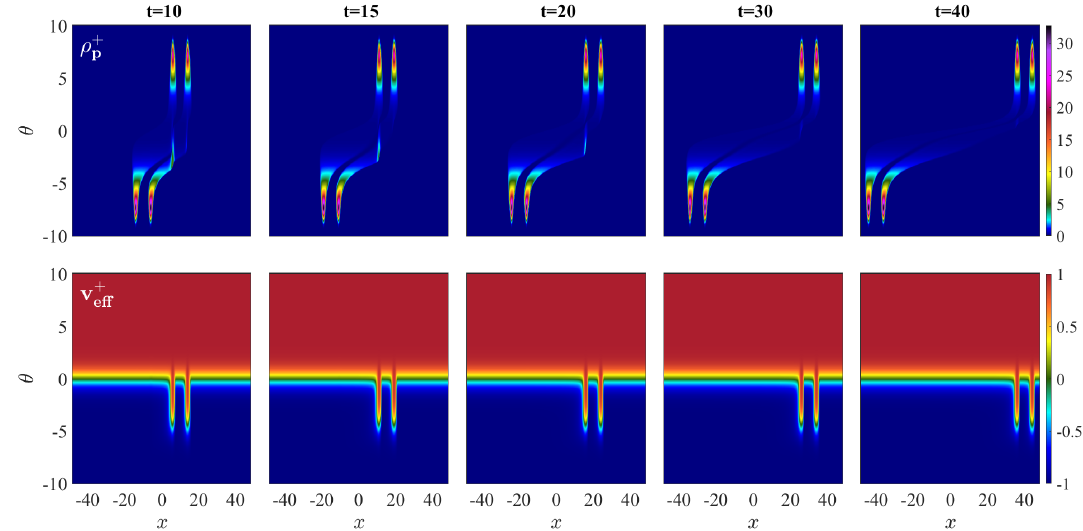
Figure 16 . Spectral density of particle + (row 1) and its effective velocity (row 2) for times t = 10 to 40 and double gaussian initial condition. The parameters are chosen here as log(2 T σ = 10 and x 0 = 4 . At late times, the decay of the left subsidiary peak lags behind the decay of the right subsidiary peak by approximately 10 time